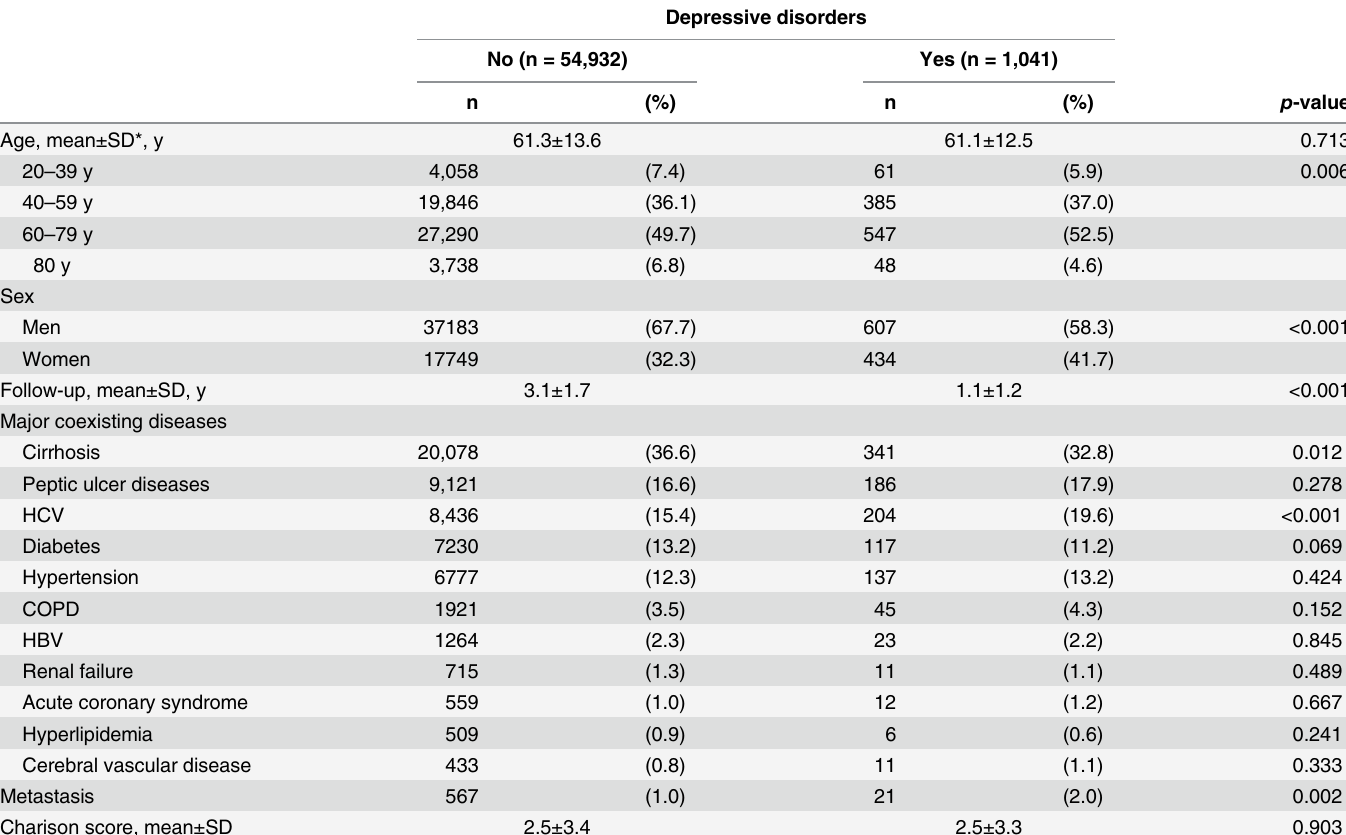
Table 2. Comparisons in demographic characteristics in HCC survivors with and without depressive disorders (n =